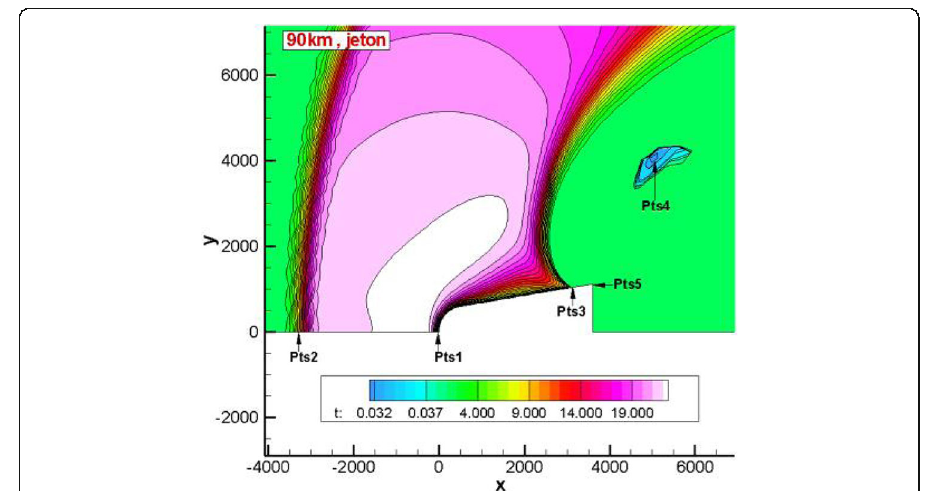
Fig. 1 Temperature contour for the jet